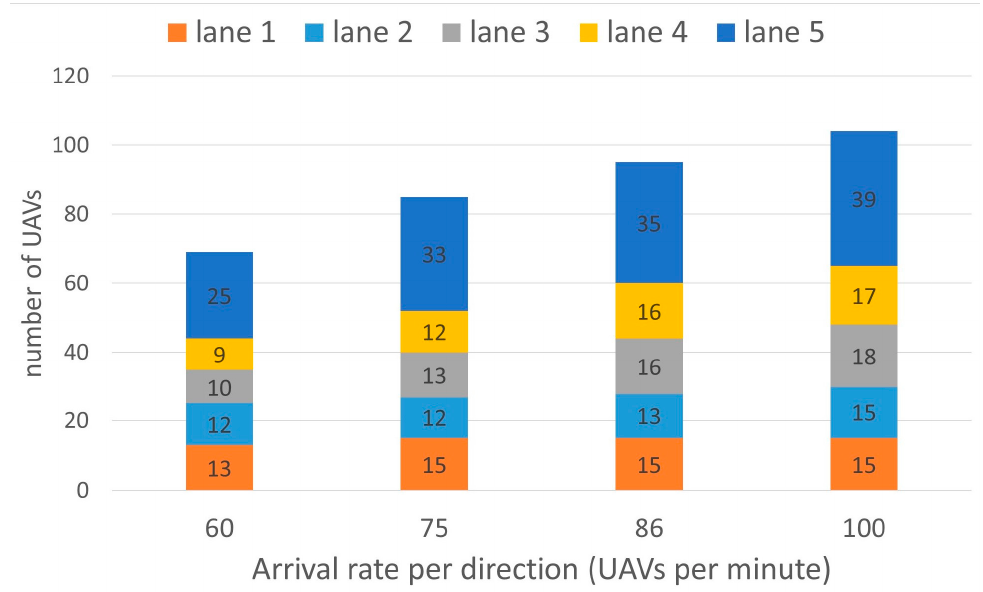
Figure 22. Number of UAVs that crossed the intersection per lane within 1 min using mode 2 and G = 80. G =